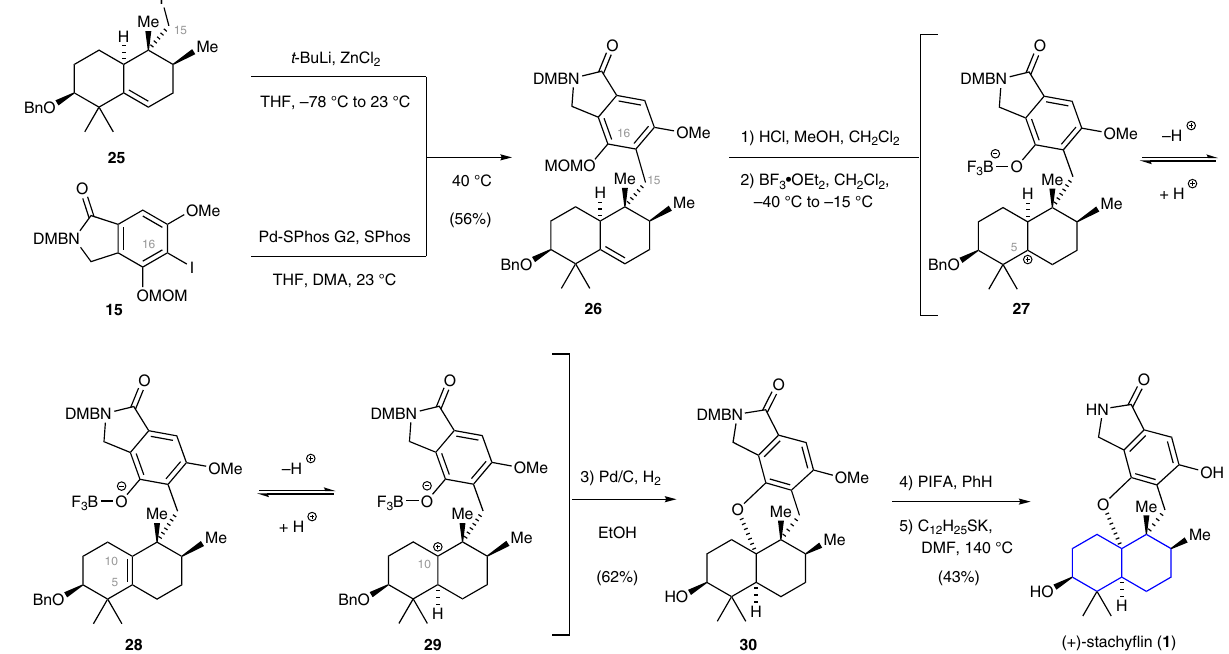
Fig. 4 Component coupling and total synthesis of (+)-stachy fl in (1). The sp 2 – sp 3 Negishi cross-coupling reaction between arene 15 and iodide 25 provided the precursor for the intended cyclization reaction. Promotion of this step was accomplished by the addition of excess boron tri fl uoride etherate (10 equiv.) at low temperature ( – 40 °C) to exclusively produce the cis -decalin 30 . At temperatures exceeding – 15 °C, competing ionization of the C3 position and ring- contraction prevailed (byproduct not shown, see Supplementary Methods). t -BuLi tert -butyllithium, DMA N , N -dimethylacetamide, PIFA phenyliodine bis (tri fl uoroacetate), SPhos 2-dicyclohexylphosphino-2 ′ ,6 ′ -dimethoxybiphenyl, SPhos-Pd G2 chloro(2-dicyclohexylphosphino-2 ′ ,6 ′ -dimethoxy-1,1 ′ -biphenyl) [2-(2 ′ -amino-1,1 ′ -biphenyl)]palladium(II)